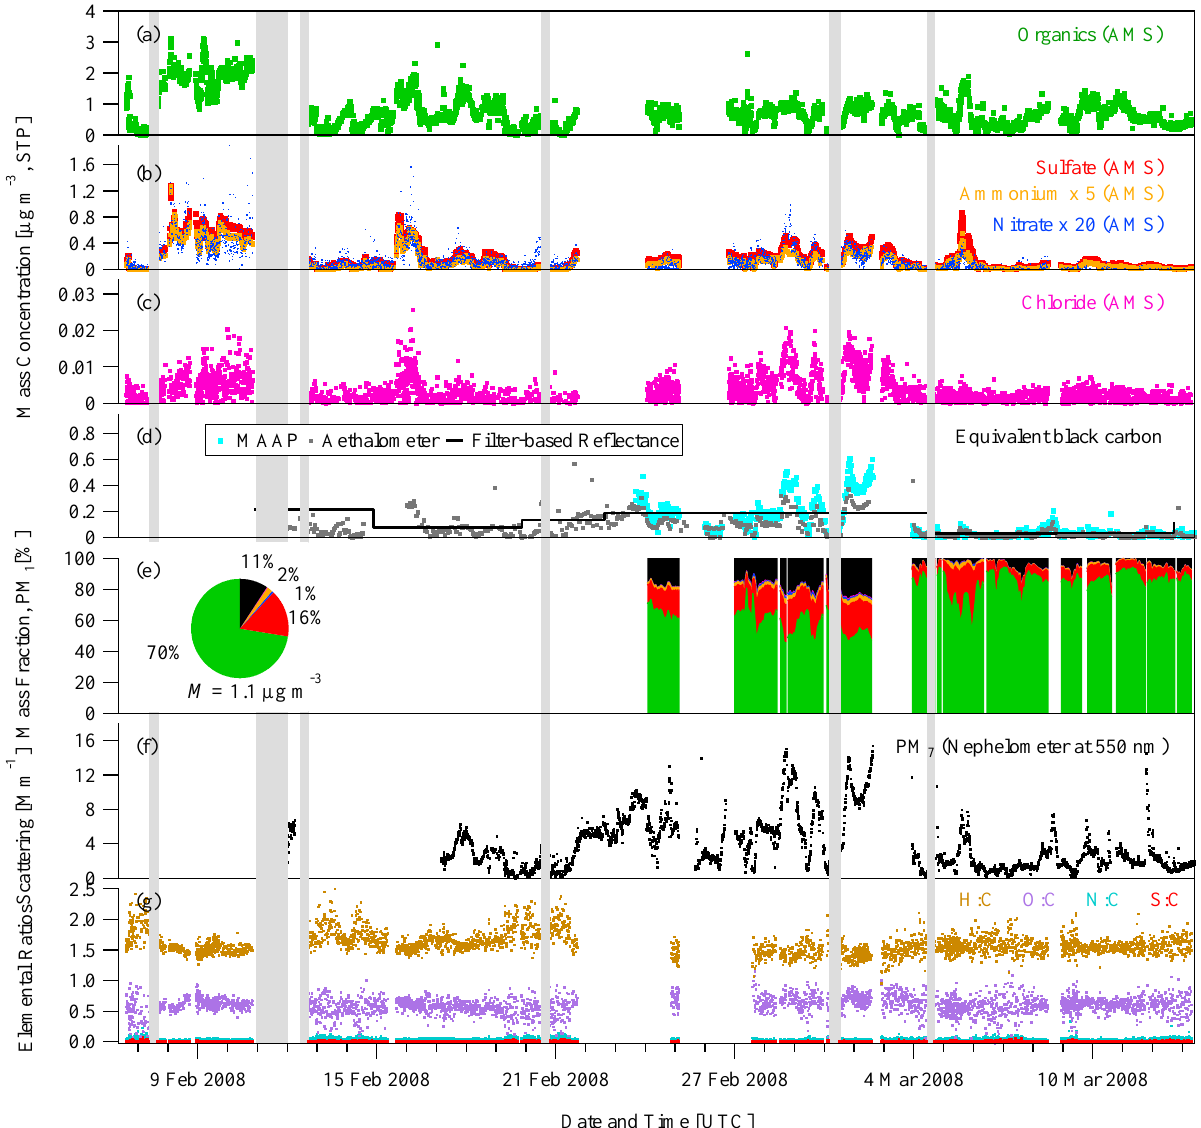
Figure 1. Time series of observations during AMAZE-08. (a, b, c) Organic, sulfate, ammonium, nitrate, and chloride mass concentrations measured by AMS. (d) Black-carbon-equivalent mass concentrations measured by filter-based reflectance (fine-mode) analysis as well as optically derived by MAAP (637nm) and aethalometer (660nm) measurements. (e) Component mass fractions of (a–d) . For (d) , MAAP data were used. The inset pie chart represents the campaign average. (f) Scattering coefficient measured by nephelometry at 550nm. Only particles of 7µm and smaller passed through the sampling inlet. (g) Elemental ratios O:C, H:C, N:C, and S:C for the submicron organic particles, as determined by high-resolution AMS data. Except for (f) , the data represent the submicron or fine-mode fraction of the ambient particle population. Concentrations are normalized to STP conditions (see main text). Periods in gray were influenced by local generator exhaust plume during times of local wind reversal and were excluded from the shown data sets and